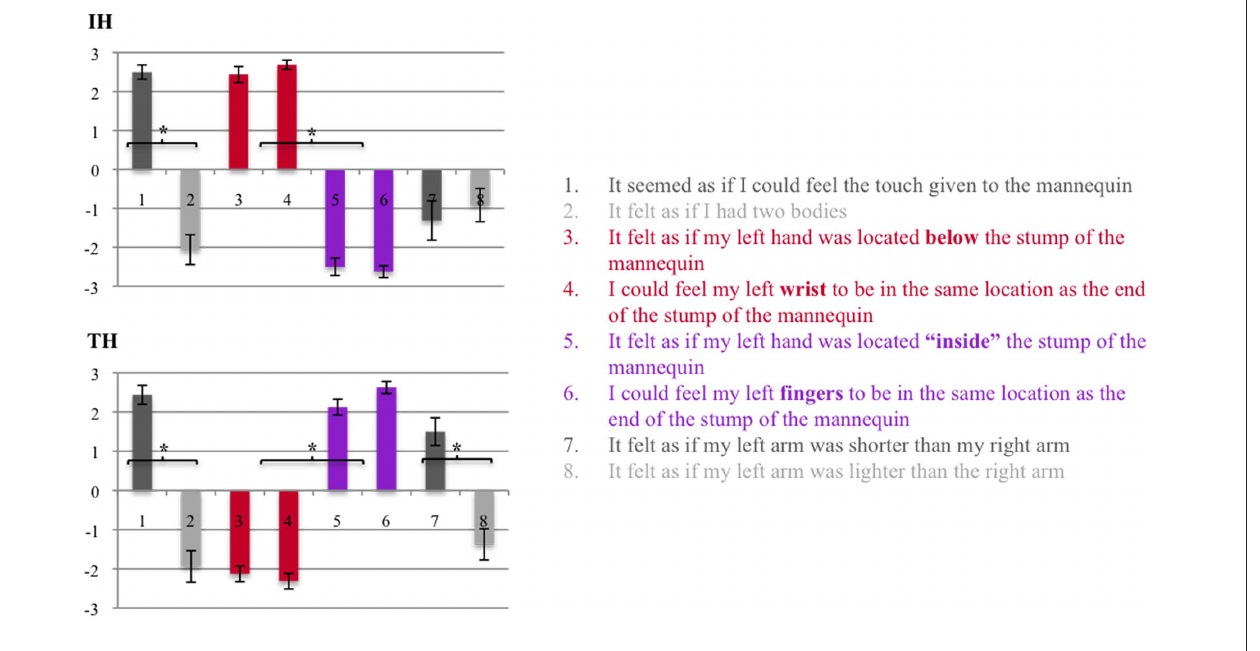
Figure 7 | experiment 3 – Questionnaire. Shortened version of the questionnaire used in Experiment 1 consisting of eight statements: Experience of the full-body illusion (Statements 1–2); Perceived location of the left hand (Statements 3–6); Perceived length of the left arm (Statements 7–8); Participants were asked to affirm or deny each statement on a seven-point Likert